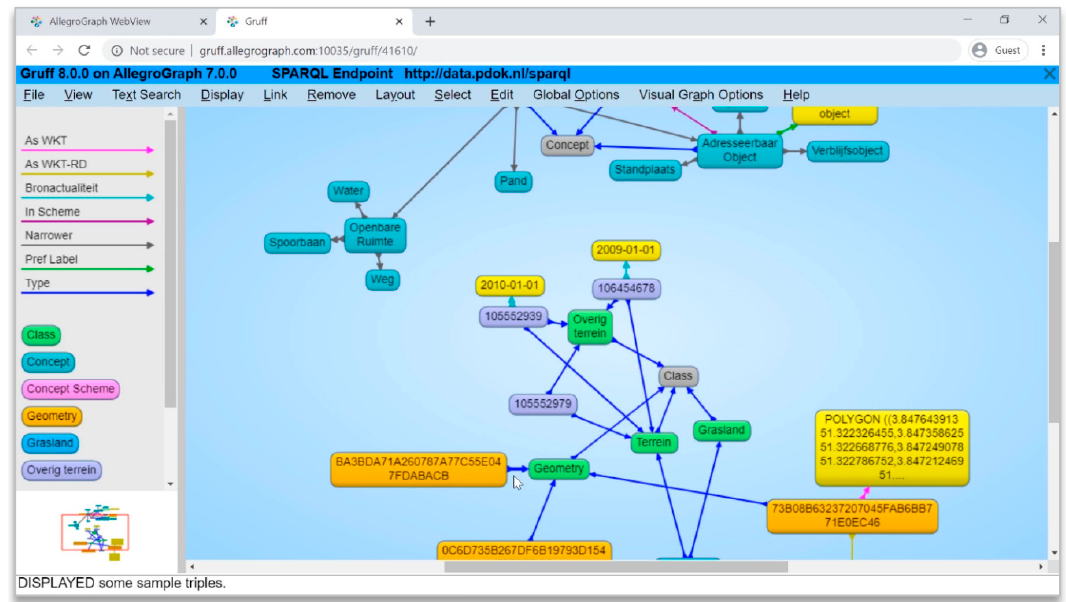
Figure 8. Gru ff Demonstrator using Basisregistratie Adressen en Gebouwen (BAG), Figure 8. Gruff Demonstrator using Basisregistratie Adressen en Gebouwen (BAG), Kadaster.